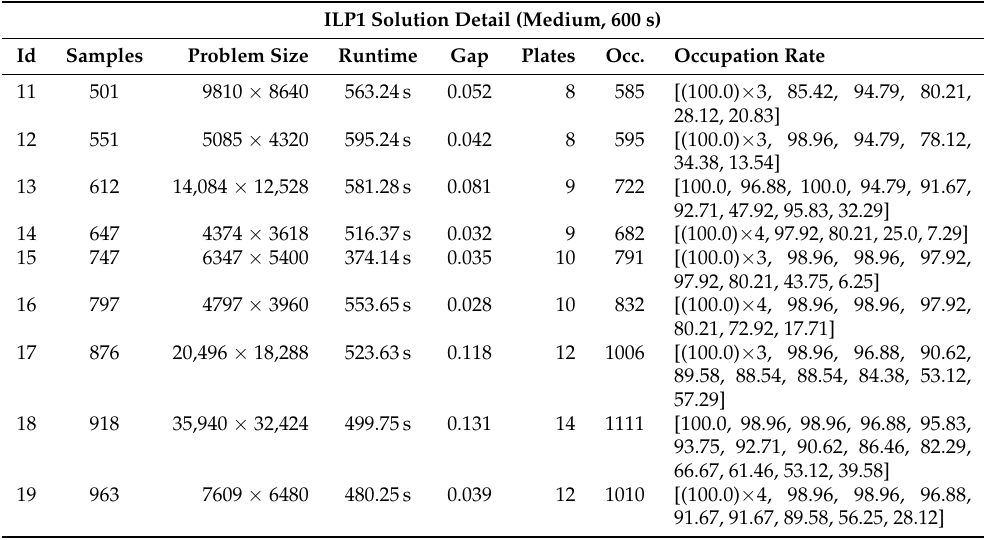
Table A6. ILP1 results obtained for medium size files, limited to 600s. Runtime column shows time stamp of best solution achieved.